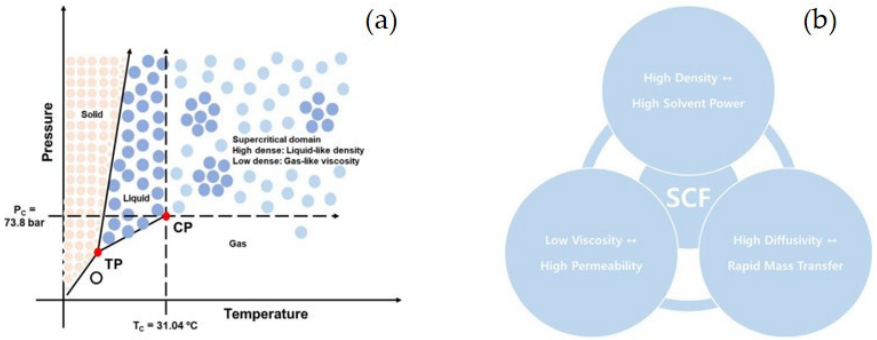
Figure 3. ( a ) Pressure and temperature phase diagram for CO 2 (TC, critical temperature; TP, critical pressure; TP, triple point; and CP, critical point) and ( b ) SCF properties (reprinted from [37] with permission, copyright Elsevier 2018).